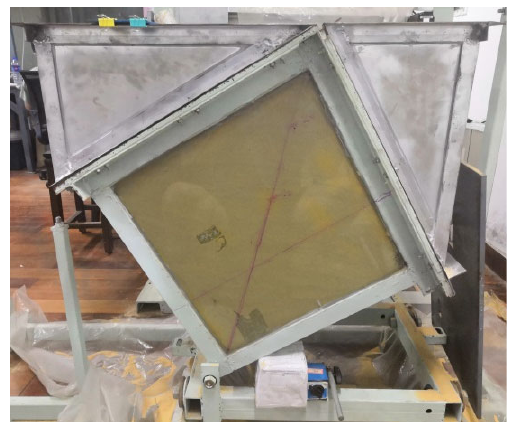
Figure 6. Photographs at soil deposition angle of 30°.